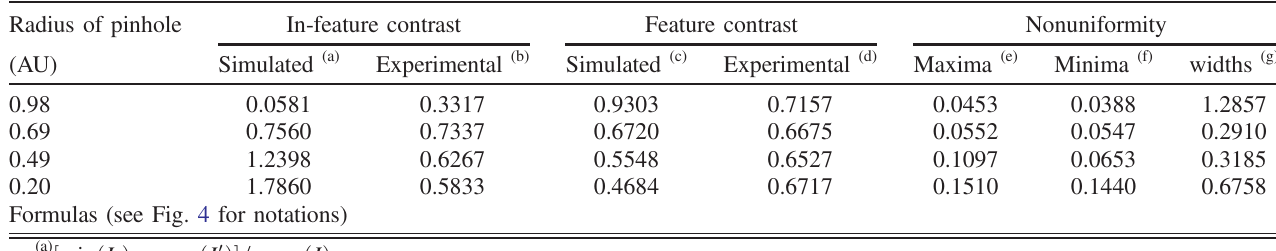
TABLE I. Quantitative assessment of images with different pinhole radii. Radius of pinhole In-feature contrast Feature contrast